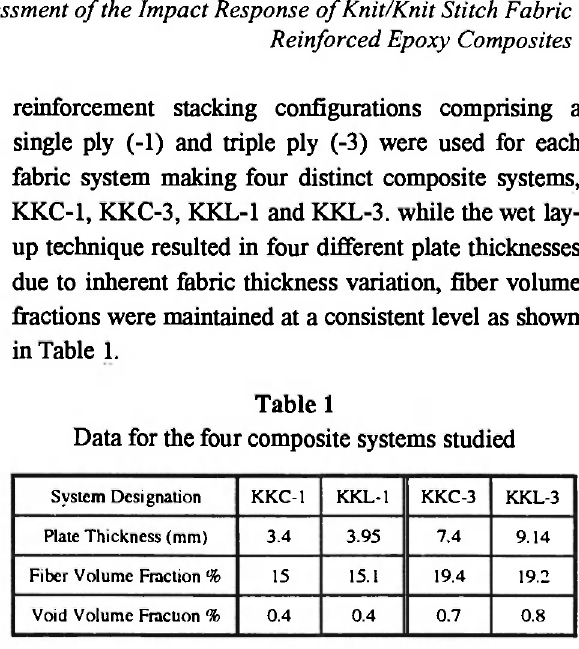
Fig. 1: Illustration of a knit/knit stitch (KKC).